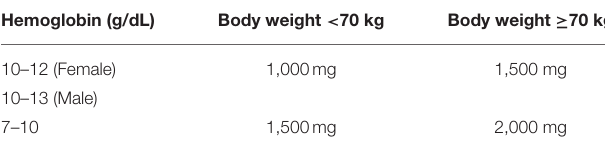
TABLE 5 | Administration of parenteral iron replacement. Hemoglobin